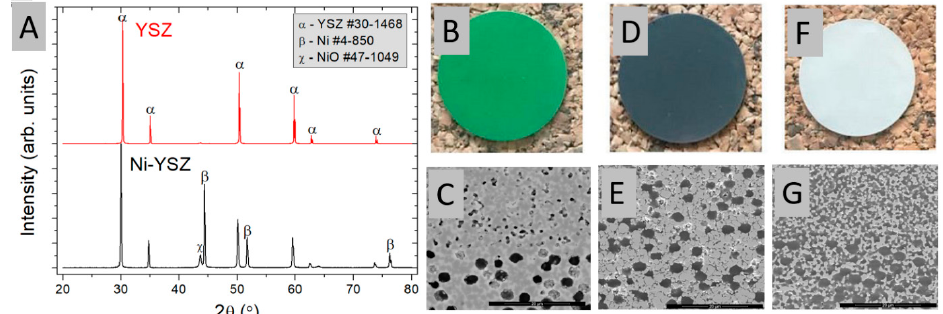
Figure 2. ( A ) XRD of samples after (top) and before (bottom) leaching, ( B , C ) optical (surface) and SEM micrograph (cross-section) of the NiO-YSZ sample before reduction and leaching, ( D , E ) Ni-YSZ after reduction, and ( F , G ) YSZ after reduction and leaching.